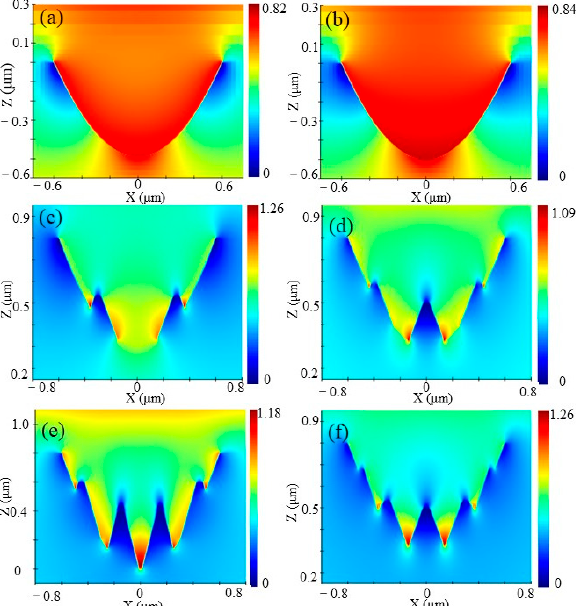
Figure 6. Optical field distribution of parabolic holes in the incident wavelength of 8 μ m ( a ) and 12 μ m ( b ), and nanoripple numbers of 2 ( c ), 3 ( d ), 4 ( e ), and 5 ( f ) in the incident wavelength of 8 μ m.